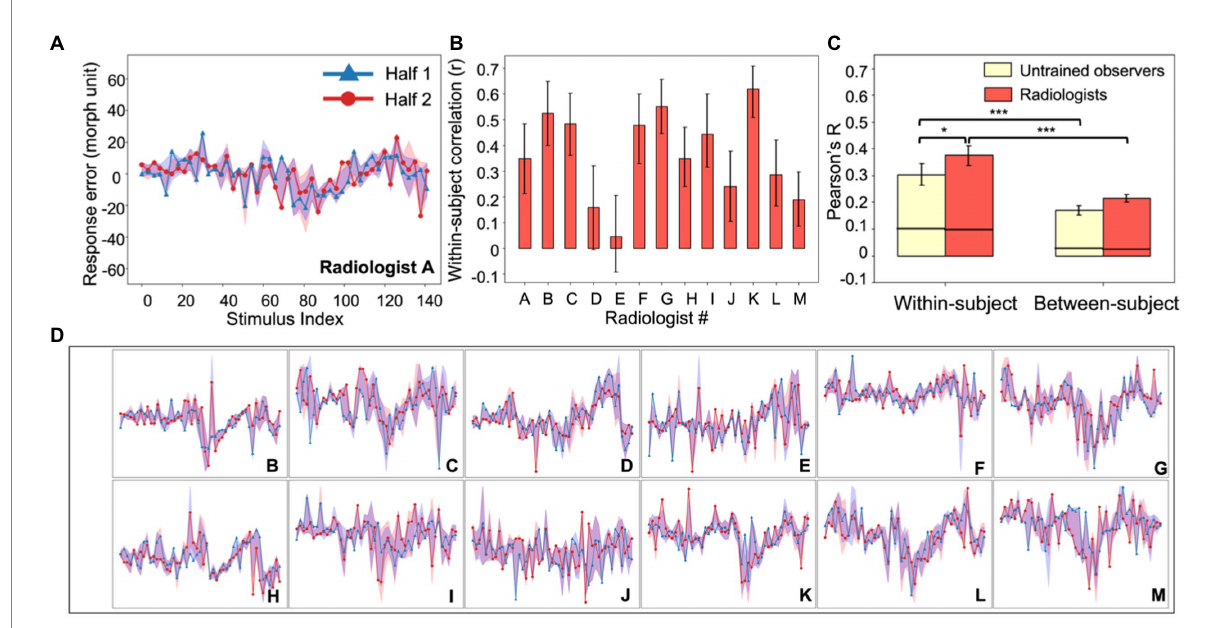
FIGURE 2 Experiment 1, individual differences in radiologists’ perception. (A) An example radiologist’s error plot. The abscissa shows the stimulus index (from Figure 1A) and the ordinate is the observer’s continuous report error. Because of the limited number of trials, data were down-sampled by binning every three neighboring simulated tumors on the continuum into one; this resulted in 49 instead of 147 data points (see Experiment 1, Data Analysis). For the purposes of visualization, we randomly split the data into two halves (red and blue curves) and plotted them separately (in the analysis this procedure was repeated, see Methods). The shaded area around the two halves represents the 95% bootstrapped confidence interval for each half. (B) The average bootstrapped split-half within-subject correlation for each radiologist. Error bars represent the 95% bootstrapped CIs for each individual radiologist. (C) Within-subject consistency and between-subject consistency were averaged within each group of observers (radiologists in red; untrained observers in yellow). For both groups, the within-subject correlations were significantly higher than between-subject correlations, and radiologists were significantly more consistent within themselves compared to untrained observers. Error bars represent the 95% bootstrapped CIs and the horizontal black lines represent the 97.5% upper bounds of the permuted null distributions. * p < 0.05, *** p < 0.001. (D) Individual radiologist’s error plots for Radiologists B-M. Strong idiosyncrasies are clear between different radiologists while at the same time there are noticeable consistencies within each radiologist, indicating stable response biases. The abscissa and ordinates for error plots in (D) are exactly the same as those in (A) so for visual simplicity, they are not